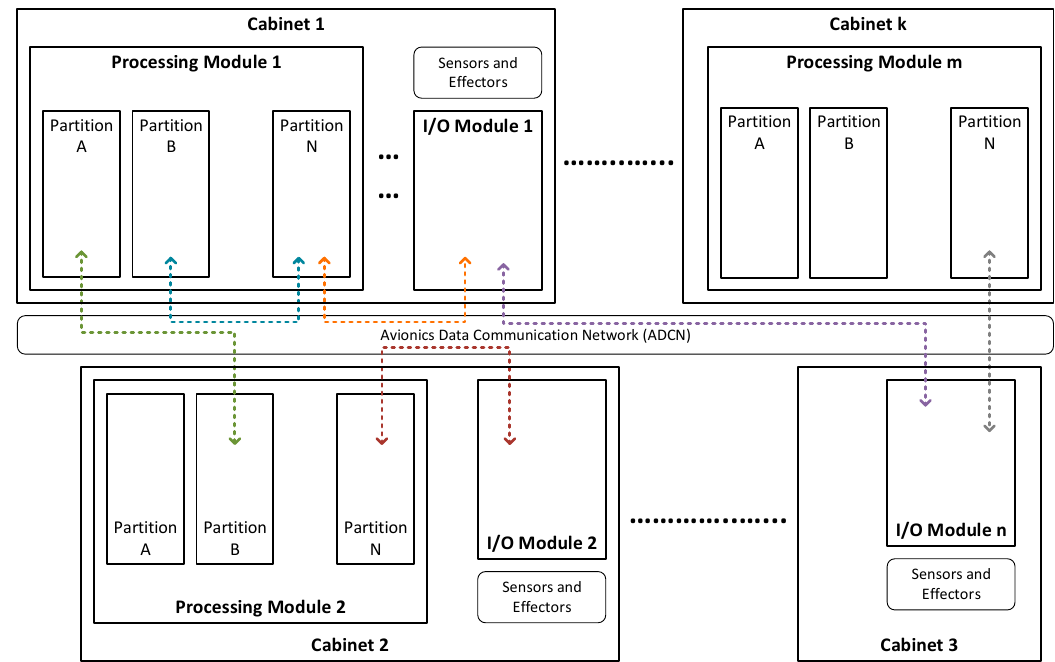
Figure 1. Space/time-partitioned architecture in Integrated Modular Avionics (IMA).